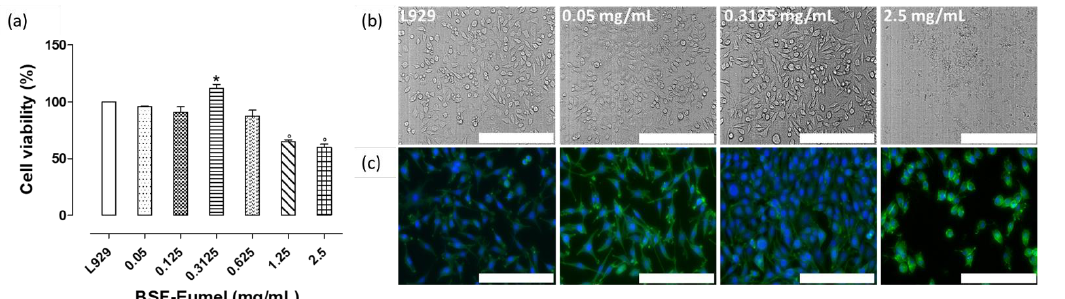
Figure 4. TEM micrographs of BSF-Eumel: ( a ) scale bar: 1 µ m, ( b ) scale bar: 200 nm. ( c ) Zeta ( ξ ) potential of BSF-Eumel as function of different conductivities and ionic strengths of medium ( di H 2 O, PBS, DMEM and DMEM + 10% ( v / v ) FBS) measured by DLS. (* p < 0.05).